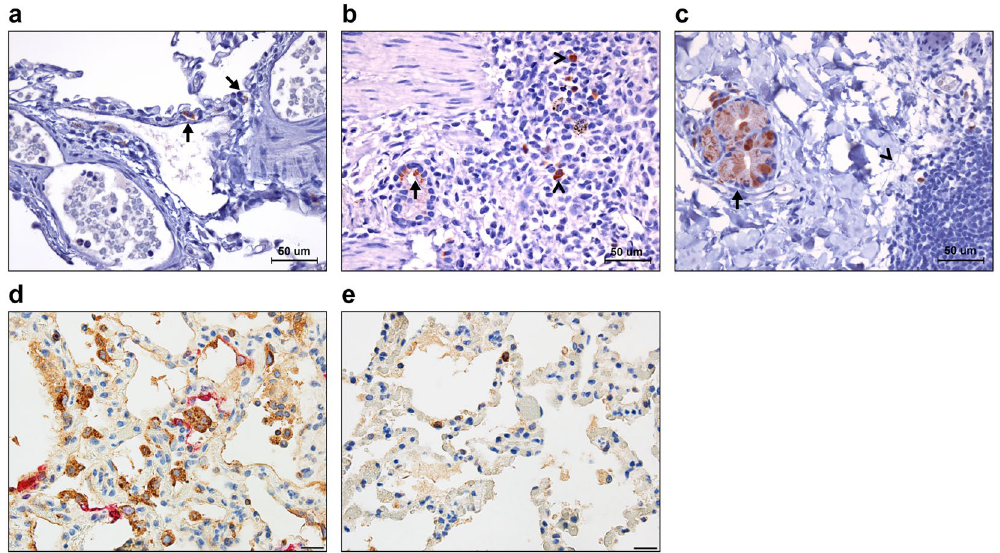
Figure 4. Immunohistochemistry of MERS spike protein in the lung. ( a ) Rare MERS spike antigen positive pneumocytes (arrows) of NHP6 at day 5 pi. ( b ) Rare MERS spike antigen positive cells in the submucosal glands (arrow) and lymphoid aggregates (^) of NHP6 at day 5 pi; ( c ) Many epithelial cells (arrow) of submucosal glands in the bronchi and fewer cells in the BALTs (^) were positive for MERS spike antigen of NHP2 at day 30 pi. ( d ) Increased numbers of alveolar macrophages that are positive for CD26 and MERS-CoV on day 5 pi. ( e ) Reduced hyperplasia and fewer CD26 + cells and alveolar macrophages were present on day 30